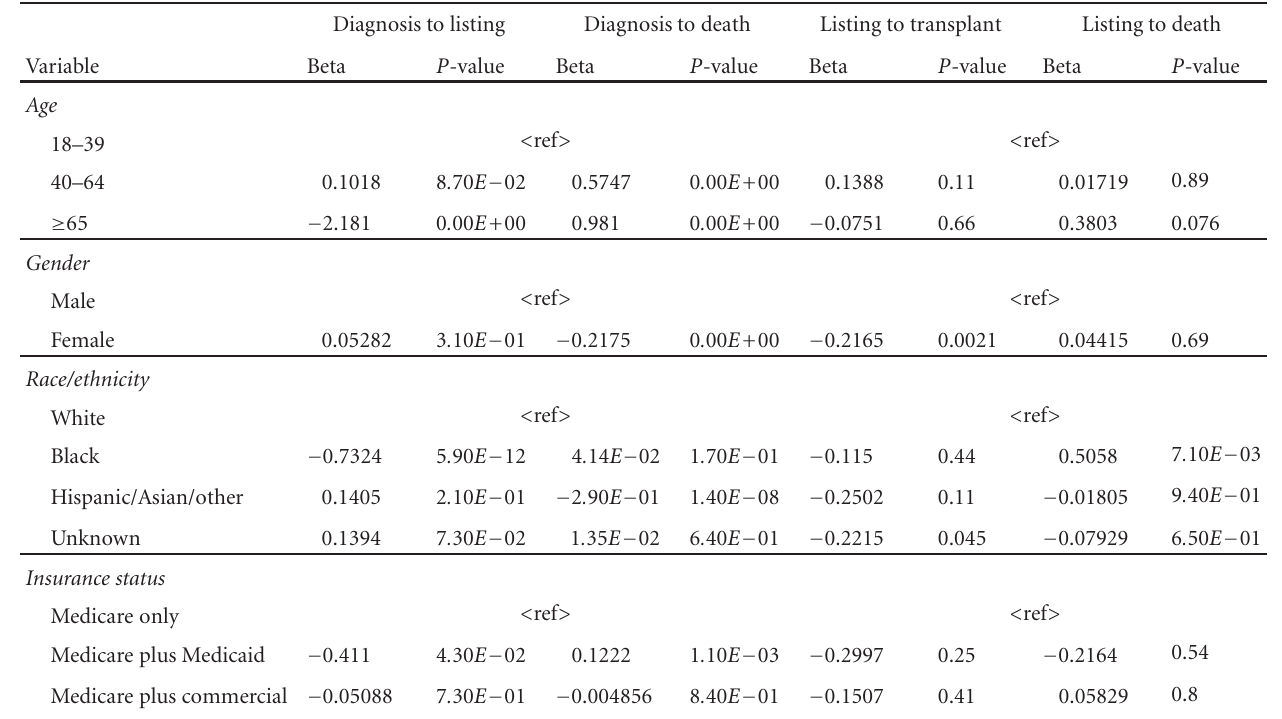
Table 3: Regressions in the multivariable competing risks model with interaction